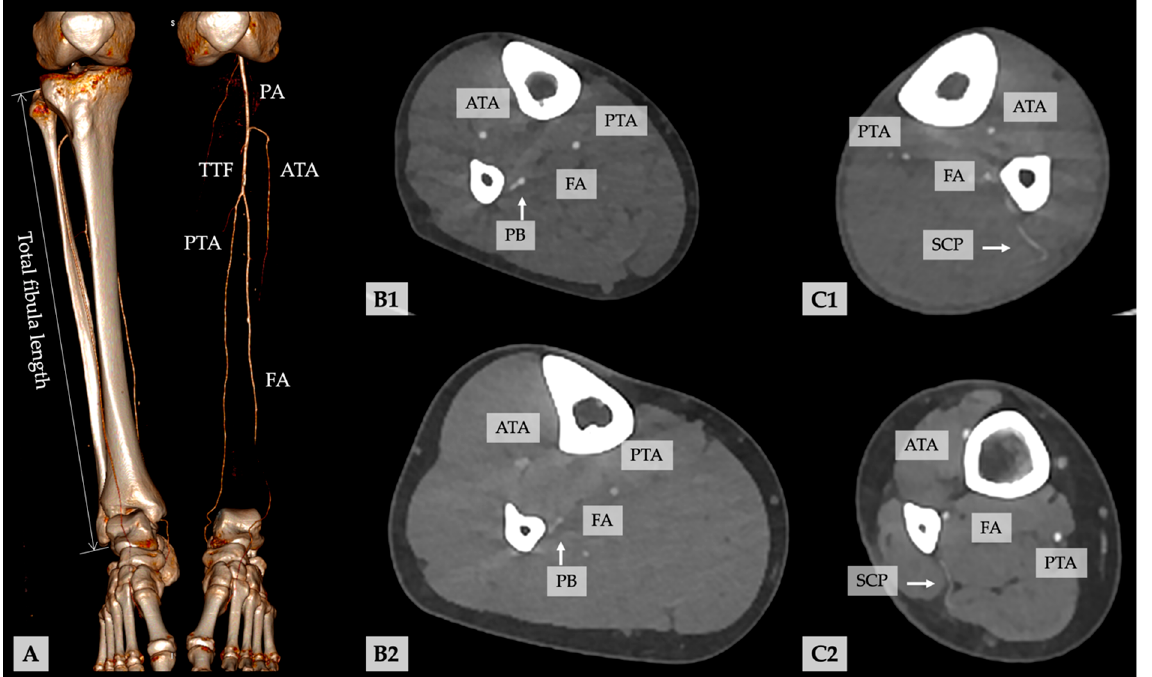
Figure 2. ( A ) Volume rendering and virtual excision of the left tibia and fibula illustrate the vessel run-off along the lower leg. ( B1,B2 ) Representative examples of periosteal branches (PB) and ( C1,C2 ) septo-cutaneous perforators (SCP) of the FA in the axial CTA planes (ATA, anterior tibial artery; FA, fibular artery; PA, popliteal artery; PTA, posterior tibial artery; TTF, truncus tibiofibularis).